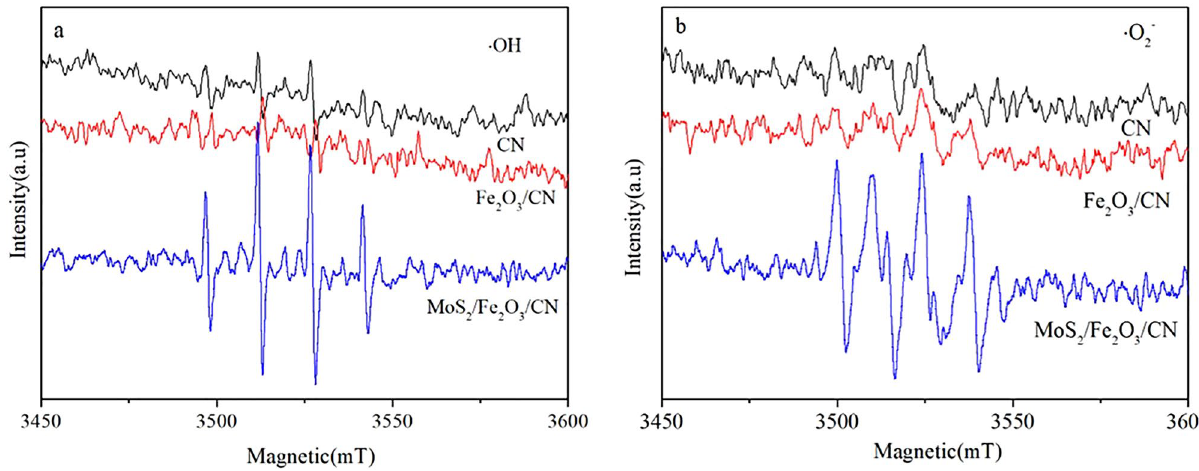
Figure 12. EPR spectra of CN, Fe 2 O 3 /CN and MoS 2 /Fe 2 O 3 /CN in different system under visible light. ( a ) DMPO − ·OH in water, ( b ) DMPO − ·O 2 − in methanol in the system.